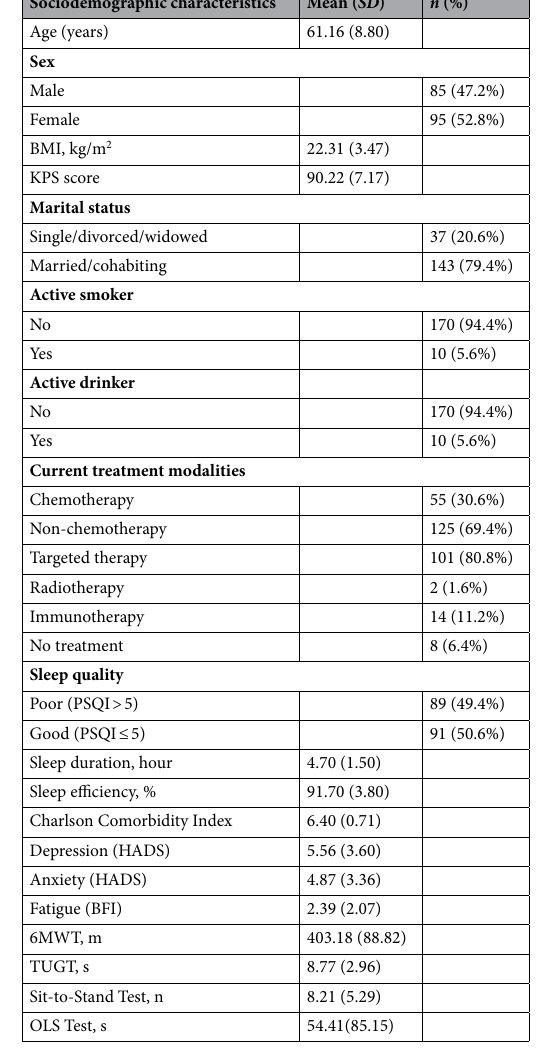
Table 1. Characteristics of the Study Sample ( N = 180). BFI Brief Fatigue Inventory, BMI body mass index, HADS Hospital Anxiety and Depression Score, KPS Karnofsky Performance Status, PSQI Pittsburgh